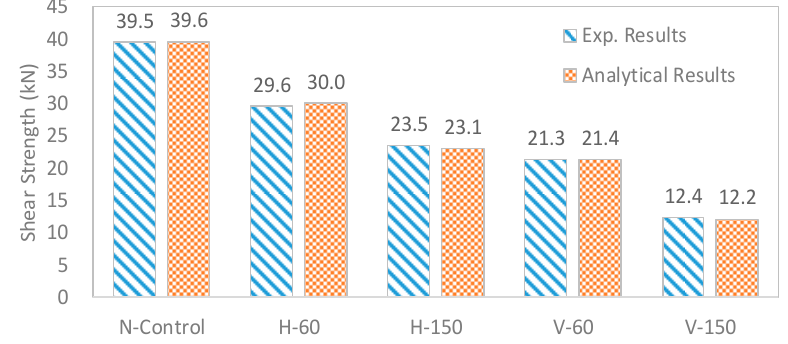
Figure 20. Obtained results of shear strength.